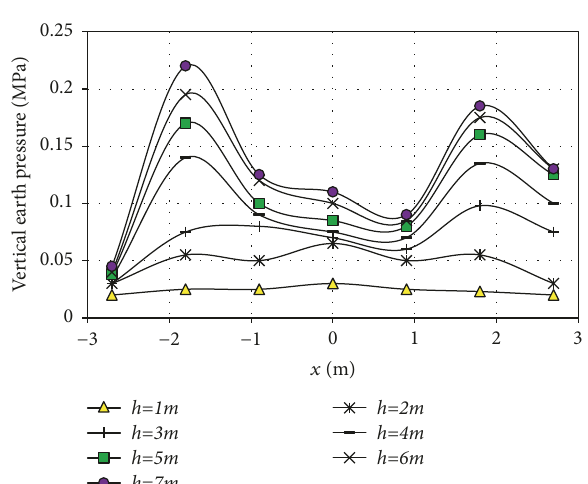
Figure 11: Distribution of lateral pressure on the left wall of section I.